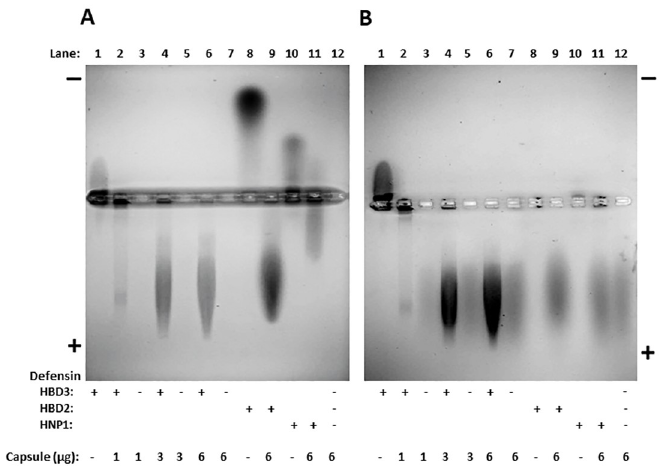
Fig 4. B . anthracis capsule binds human beta and alpha defensins. 3 μ g of HBD-3, HBD-2, or HNP-1 was incubated with or without 1, 3, or 6 μ g capsule for 30 min at 37˚C. Samples were then electrophoresed in a 1% TAE agarose gel at 100 V at 4˚C for 1 h. Defensins were stained with GelCode Blue (A) and then capsule was visualized in the same gel with Stains-All (B), as described in Materials and Methods. The white ring around the wells is an artifact due to the reflection of the overhead light off of the raised rims of the wells. Three experiments were run (n = 3). A representative gel is shown.